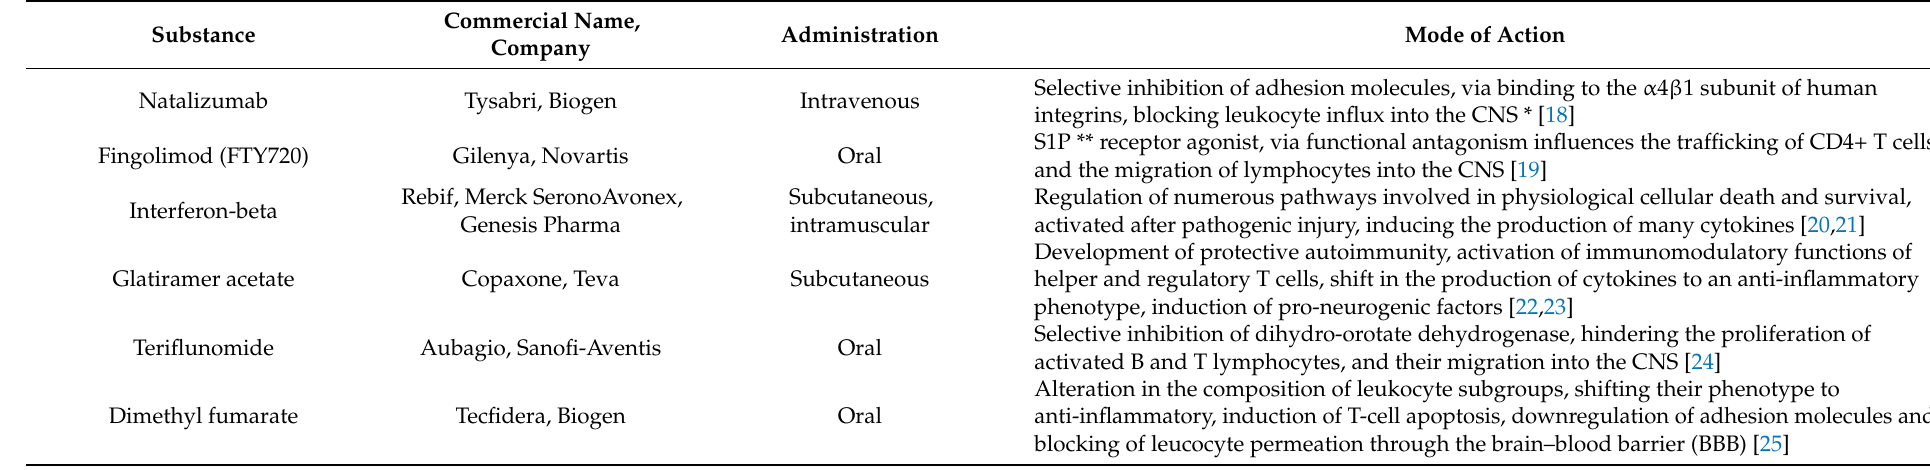
Table 1. Basic Characteristics and Modes of Action of the Included multiple sclerosis (MS) disease modifying drugs (DMDs).